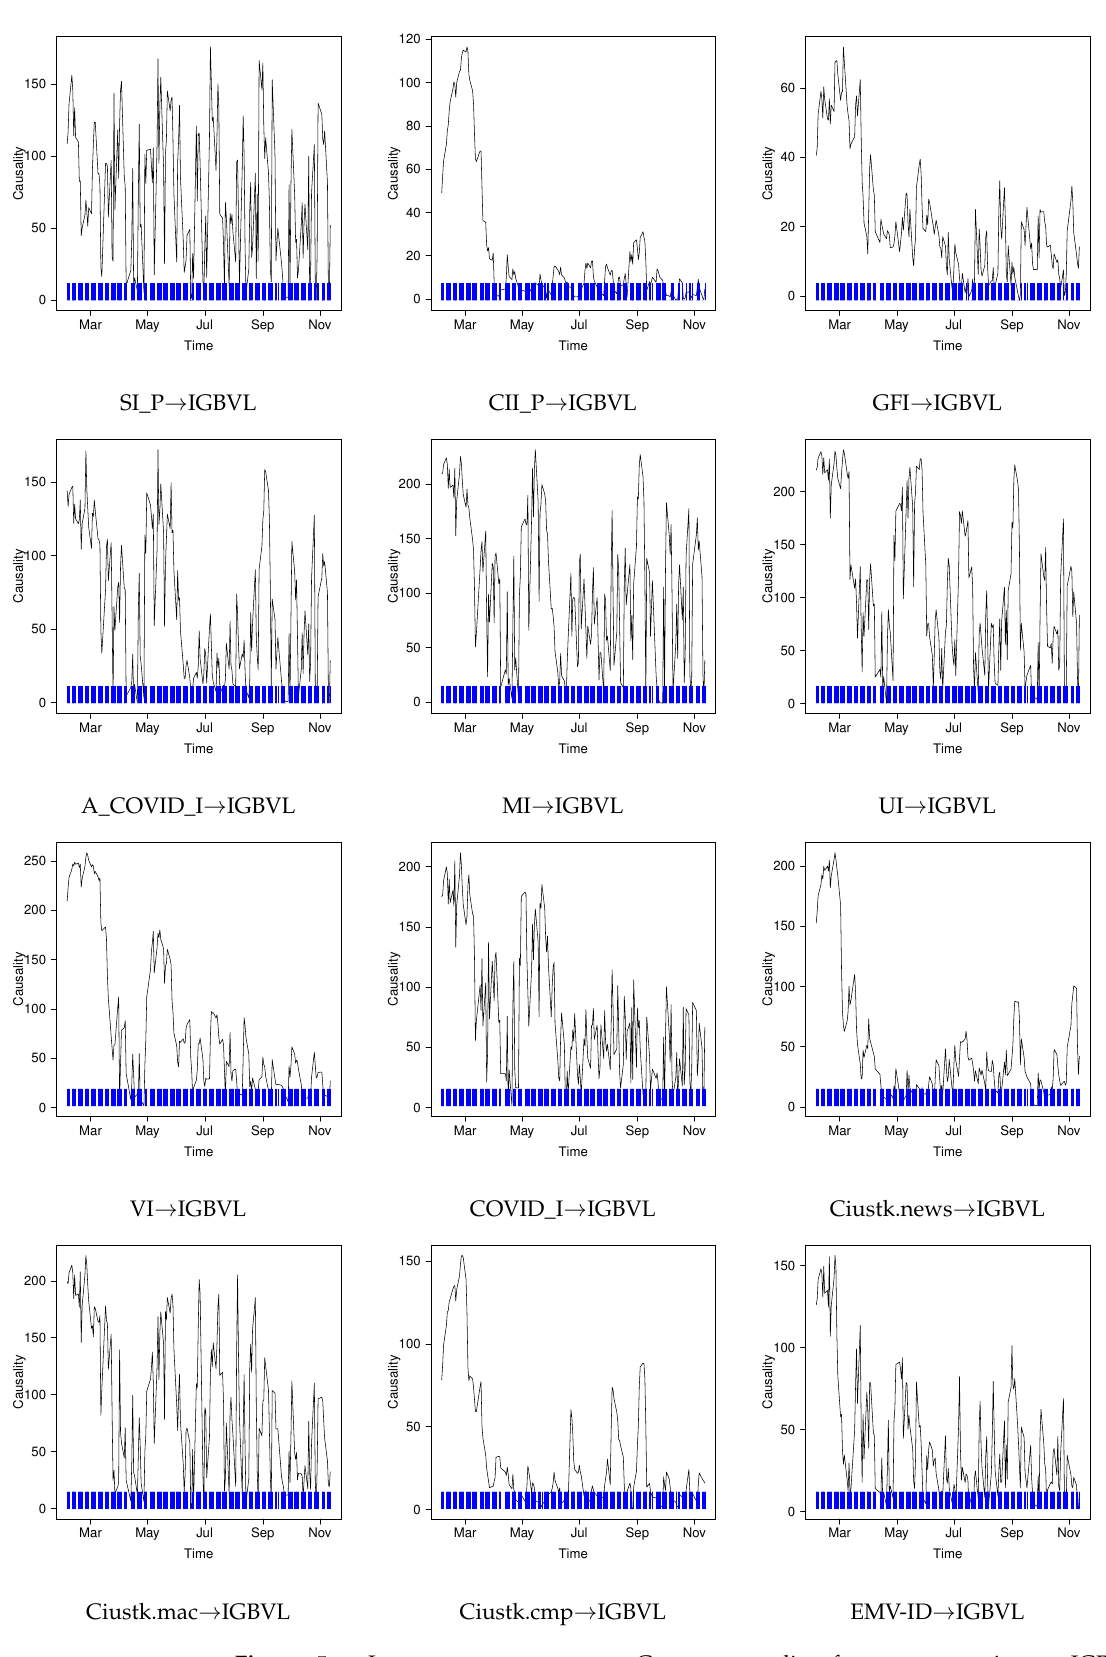
Figure 5. Instantaneous, one-way Granger-causality from news series to IGBVL (DCC- GARCH